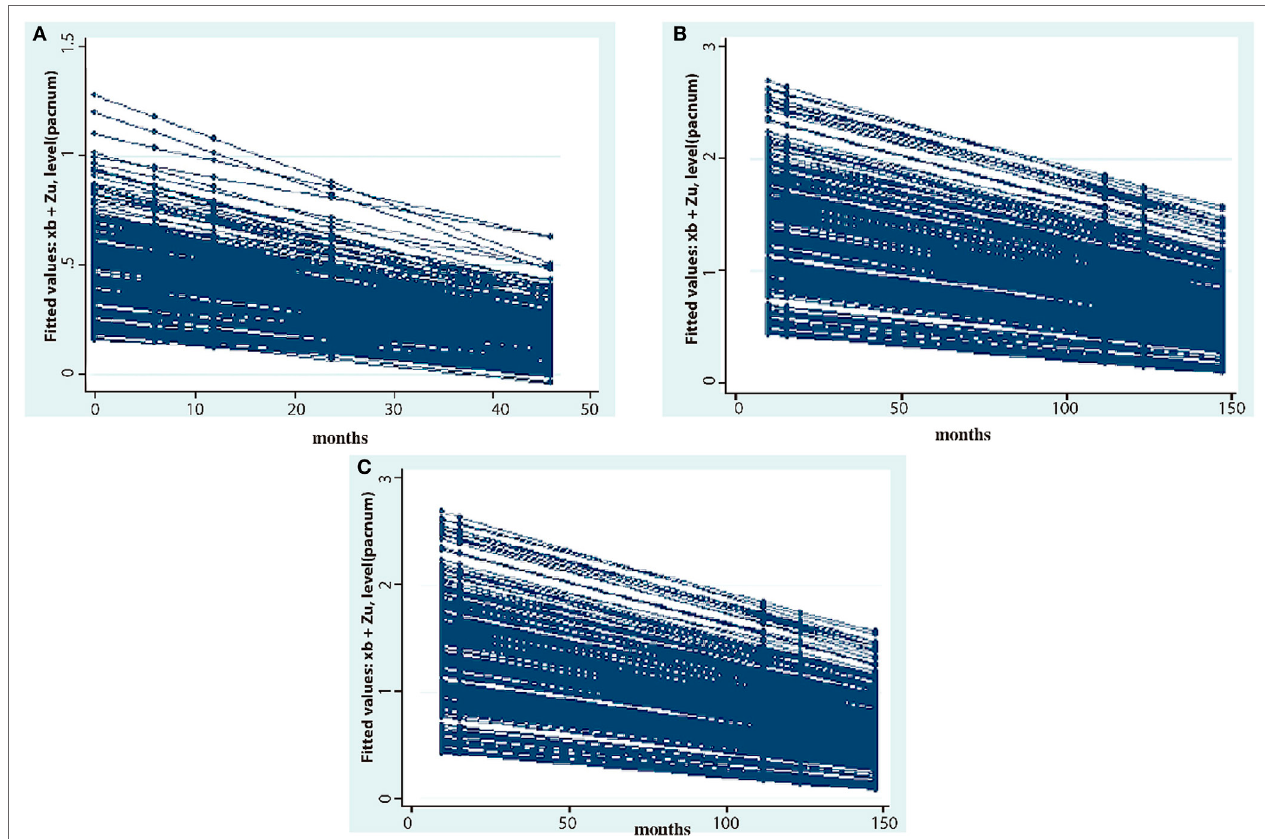
FigUre 4 | Mixed effect multilevel analyses of 244 patients treated either with regular multidrug therapy (R-MDT) or the uniform multidrug therapy (U-MDT) showing the decay of antibody responses to different Mycobacterium leprae antigens (optical density, y axis) overtime (months, x axis): (a) phenollic glycolipid-I antigen, (B) LID-1, (c)